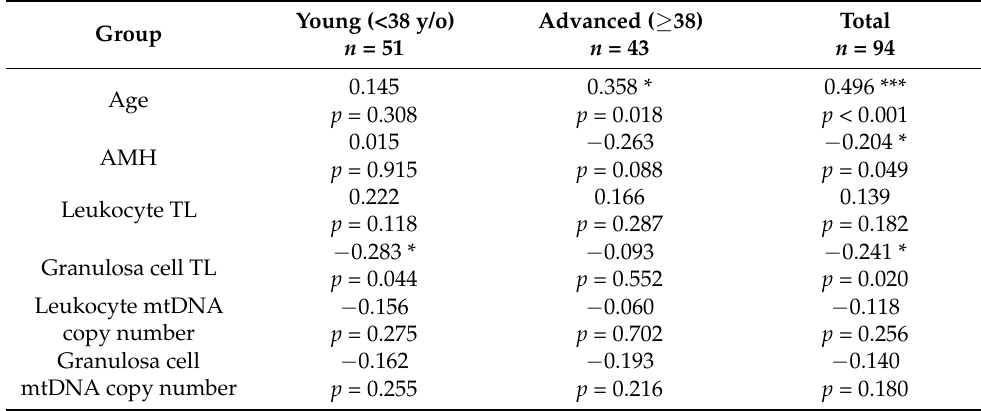
Figure 2. Correlation between cell senescence markers (telomere length and mitochondrial DNA copy number) in granulosa cells or leukocytes. ( A ) telomere length vs. mitochondrial DNA copy number in leukocytes. ( B ) telomere length vs. mitochondrial DNA copy number in granulosa cells. ( C ) telomere length in granulosa cells vs. leukocytes. ( D ) mitochondrial DNA copy number in granulosa cells vs. leukocytes. Table 3. The correlation of aging biomarkers with aneuploidy rates (Spearman correlation coefficient) in the ART cycles with